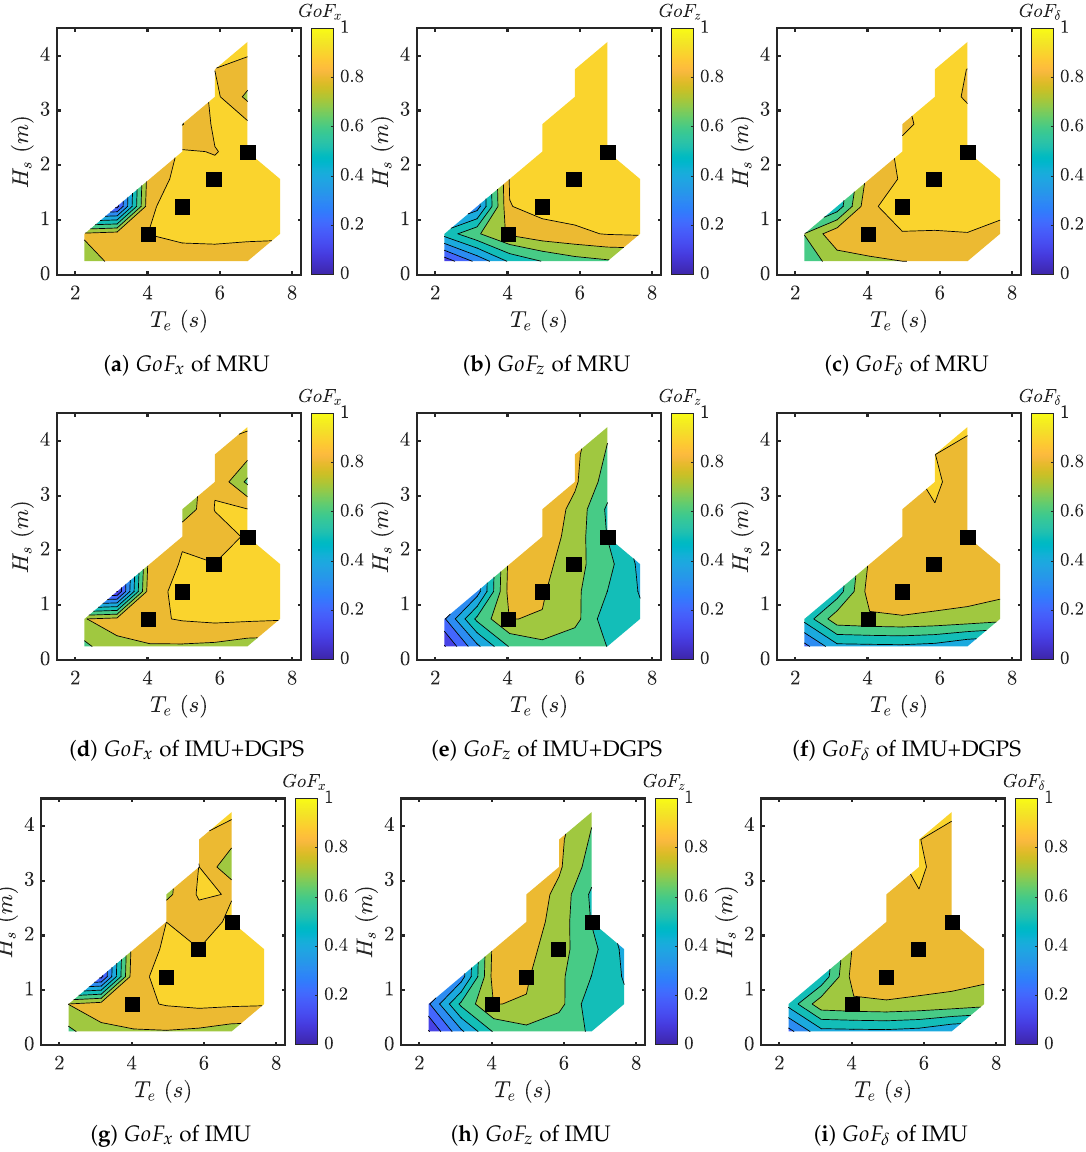
Figure A3. GoF results with noisy measurements for each measurement framework obtained with the KF. The first row refers to the MRU framework ( a – c ), the second to the IMU+DGPS framework ( d – f ), the thrid to the IMU framework ( g – i